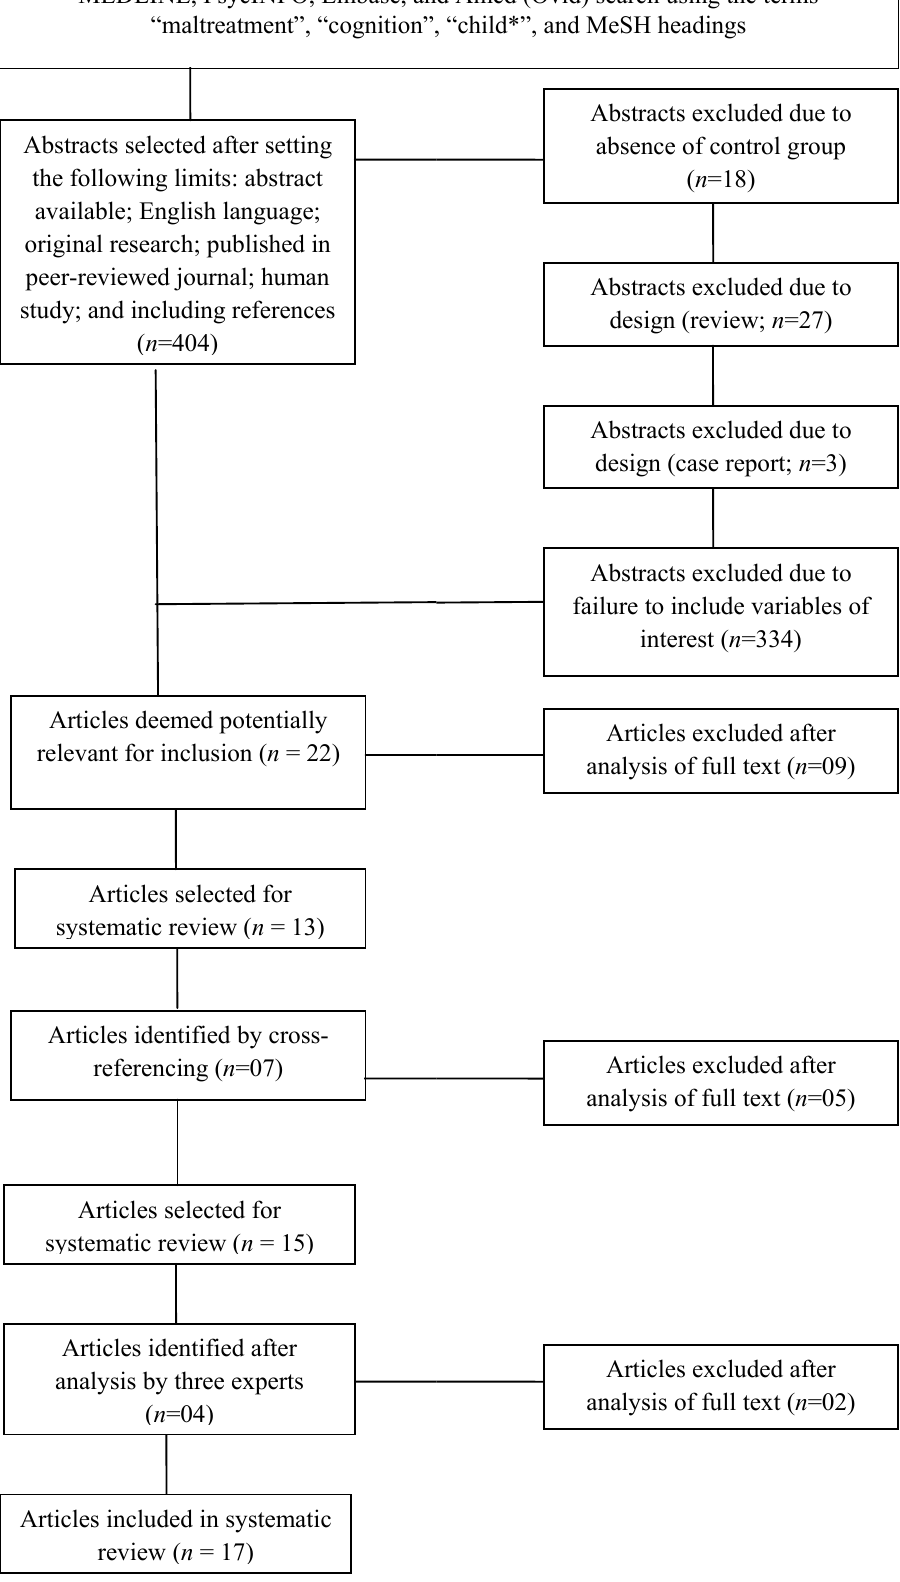
Figure 1 . Article selection fl